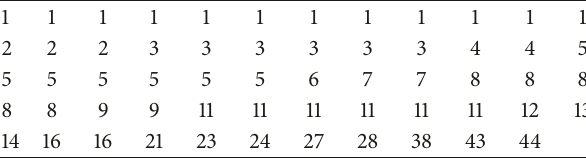
Table 5: Dataset related to the sugarcane harvester’s Pricker